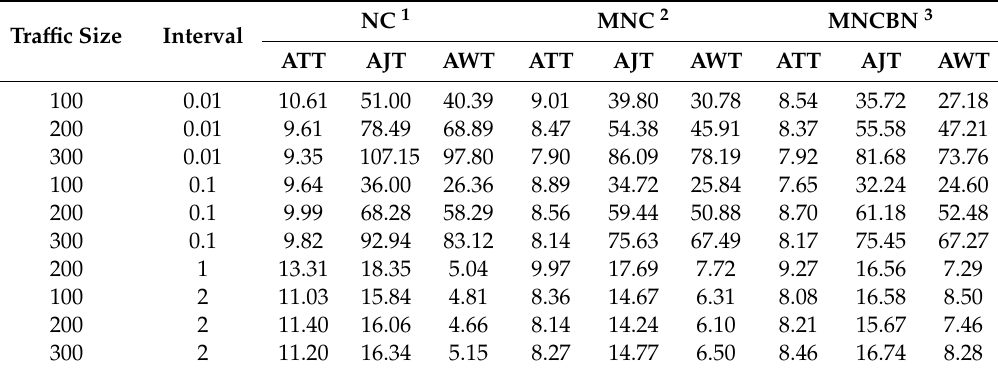
Table 2. Simulation results for the downpeak tra ffi c pattern.